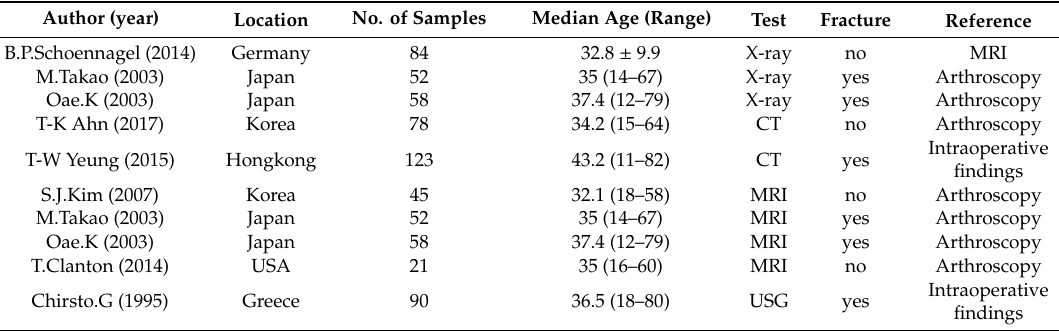
Figure 1. Flow chart of the included studies. Table 1. Characteristics and results of the included